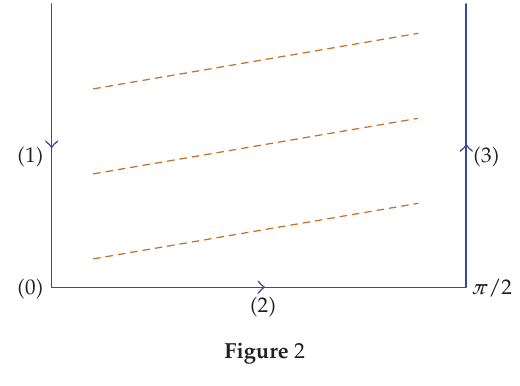
(cid:10) √ z tan x 0